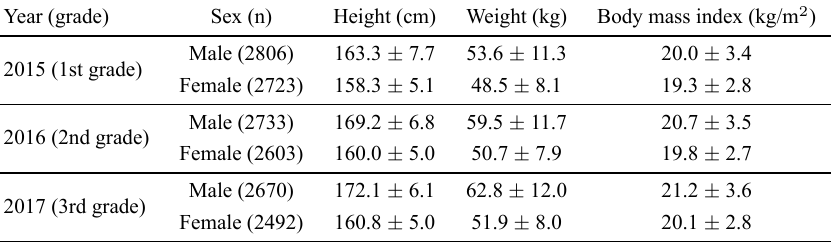
Table 1. General characteristics of research